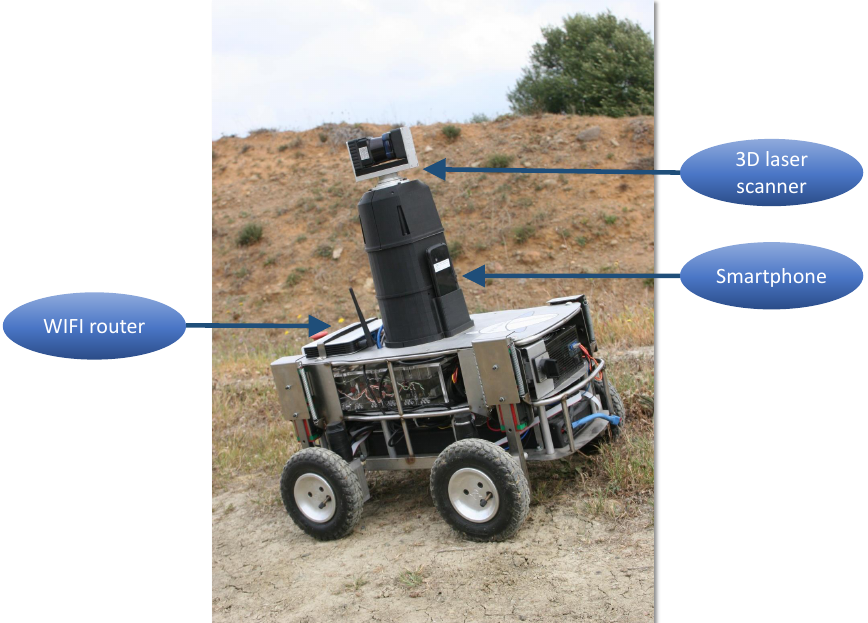
Figure 1. The Andabata mobile robot with the 3D laser scanner on